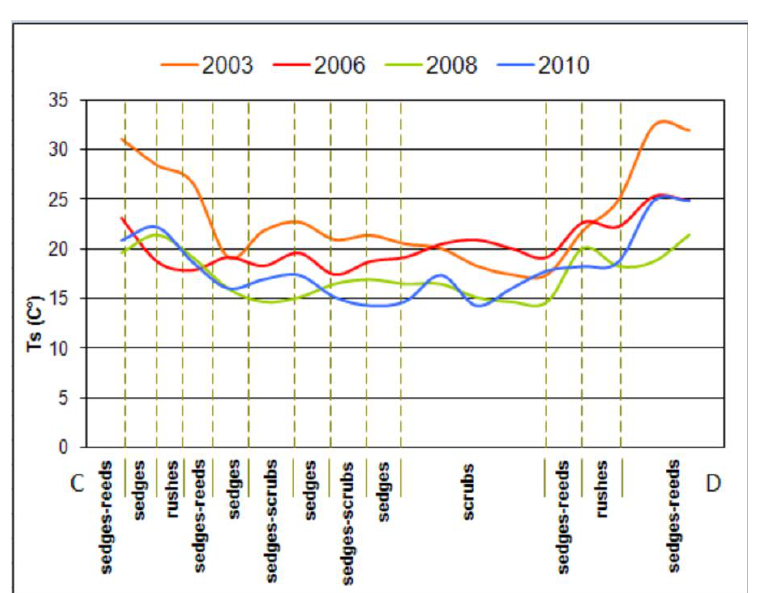
Figure 16. T along the transect C–D calculated from AVHRR s